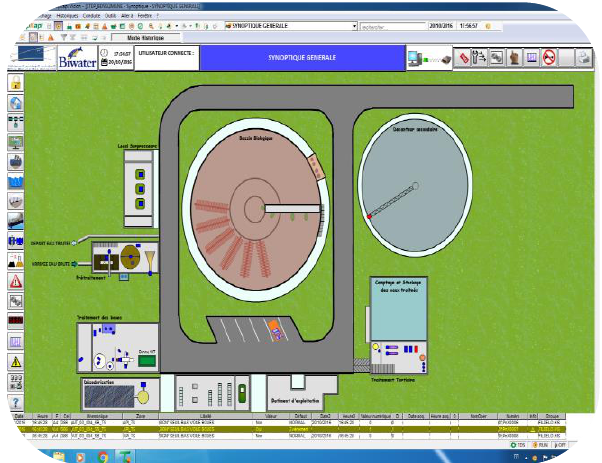
Figure 1. Wastewater treatment system of the WWTP by activated sludge